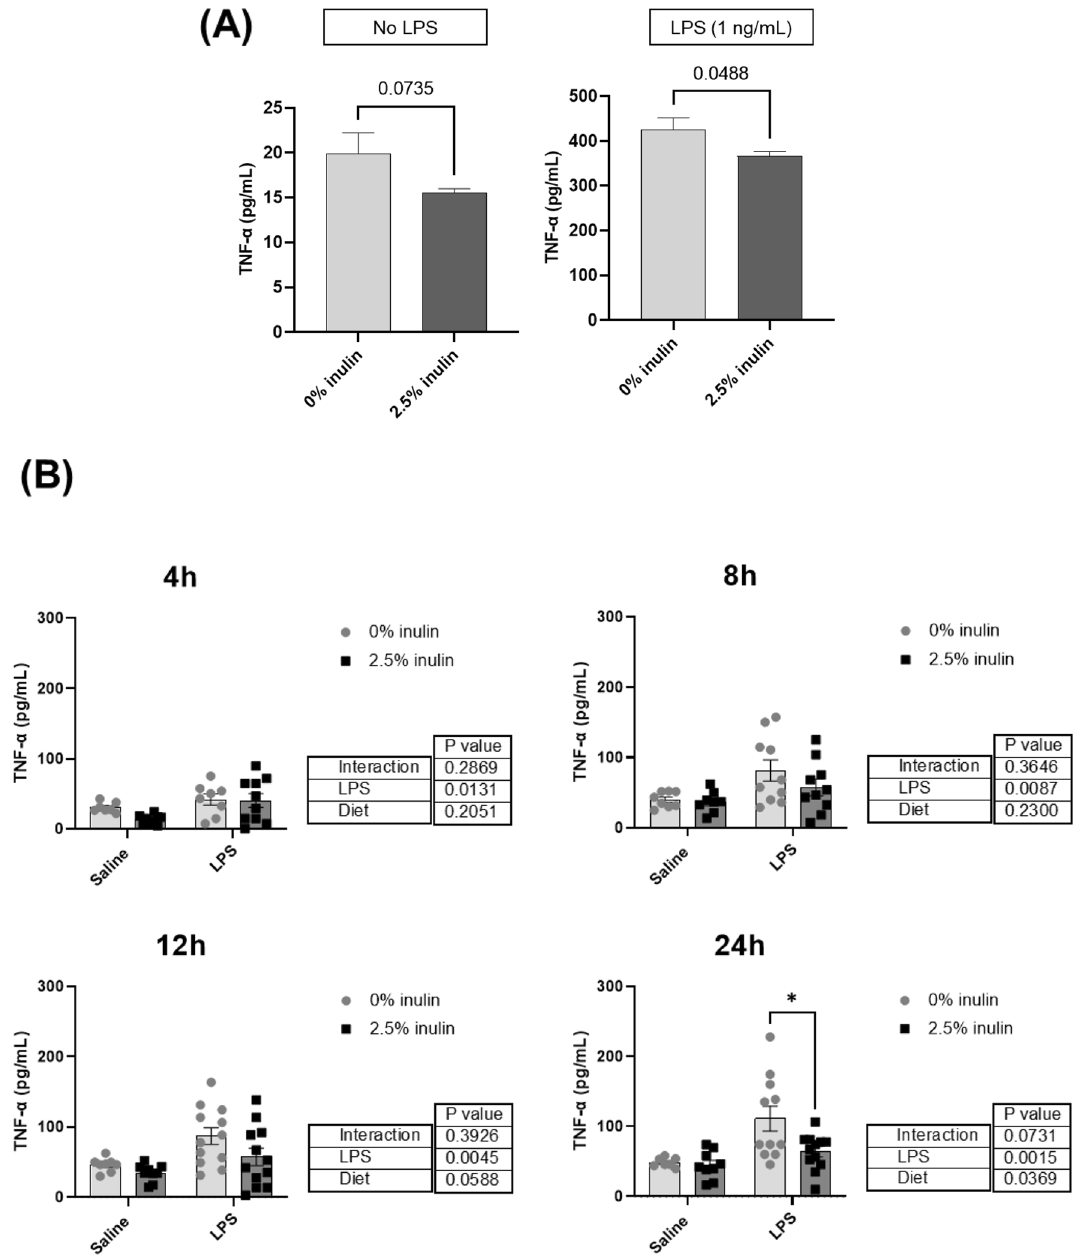
Figure 2. Effect of dietary fiber intake on the TNF-α protein secretion (measured by ELISA) by primary microglia from mice fed 0 or 2.5% inulin for 2 months. TNF-α secretion by microglia was measured ( A ) after isolating and stimulating in vitro with LPS (0 or 1 ng/mL) or ( B ) after injecting mice i.p. with LPS (0 or 500 µg/ kg) 4 h before isolating and culturing microglia 4 h, 8 h, 12 h, or 24 h. In ( A ), samples (0 or 2.5% inulin) were compared by unpaired t-test. Statistical difference between inulin levels was considered for P < 0.05. In ( B ), samples were analyzed by 2-way ANOVA (2 × 2 factorial arrangement of LPS and diet), followed by Šidák’s multiple comparisons test (* P <